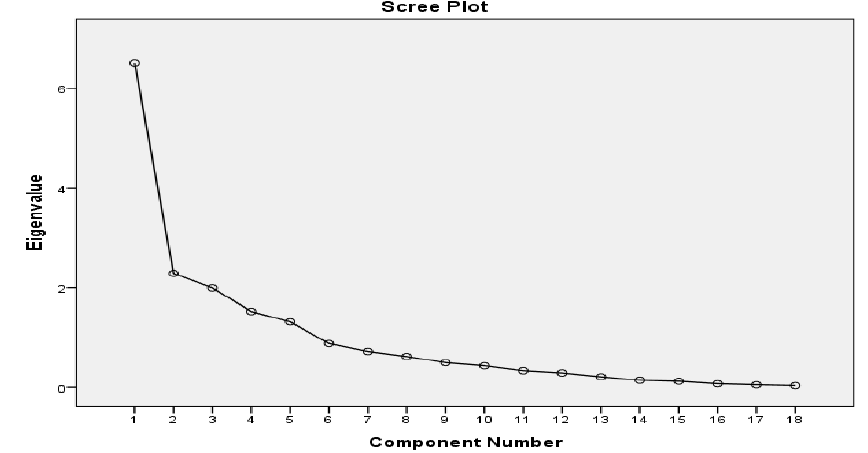
Figure 3. Scree plot. Source: Authors’ own contribution, based on data provided by EUROSTAT.